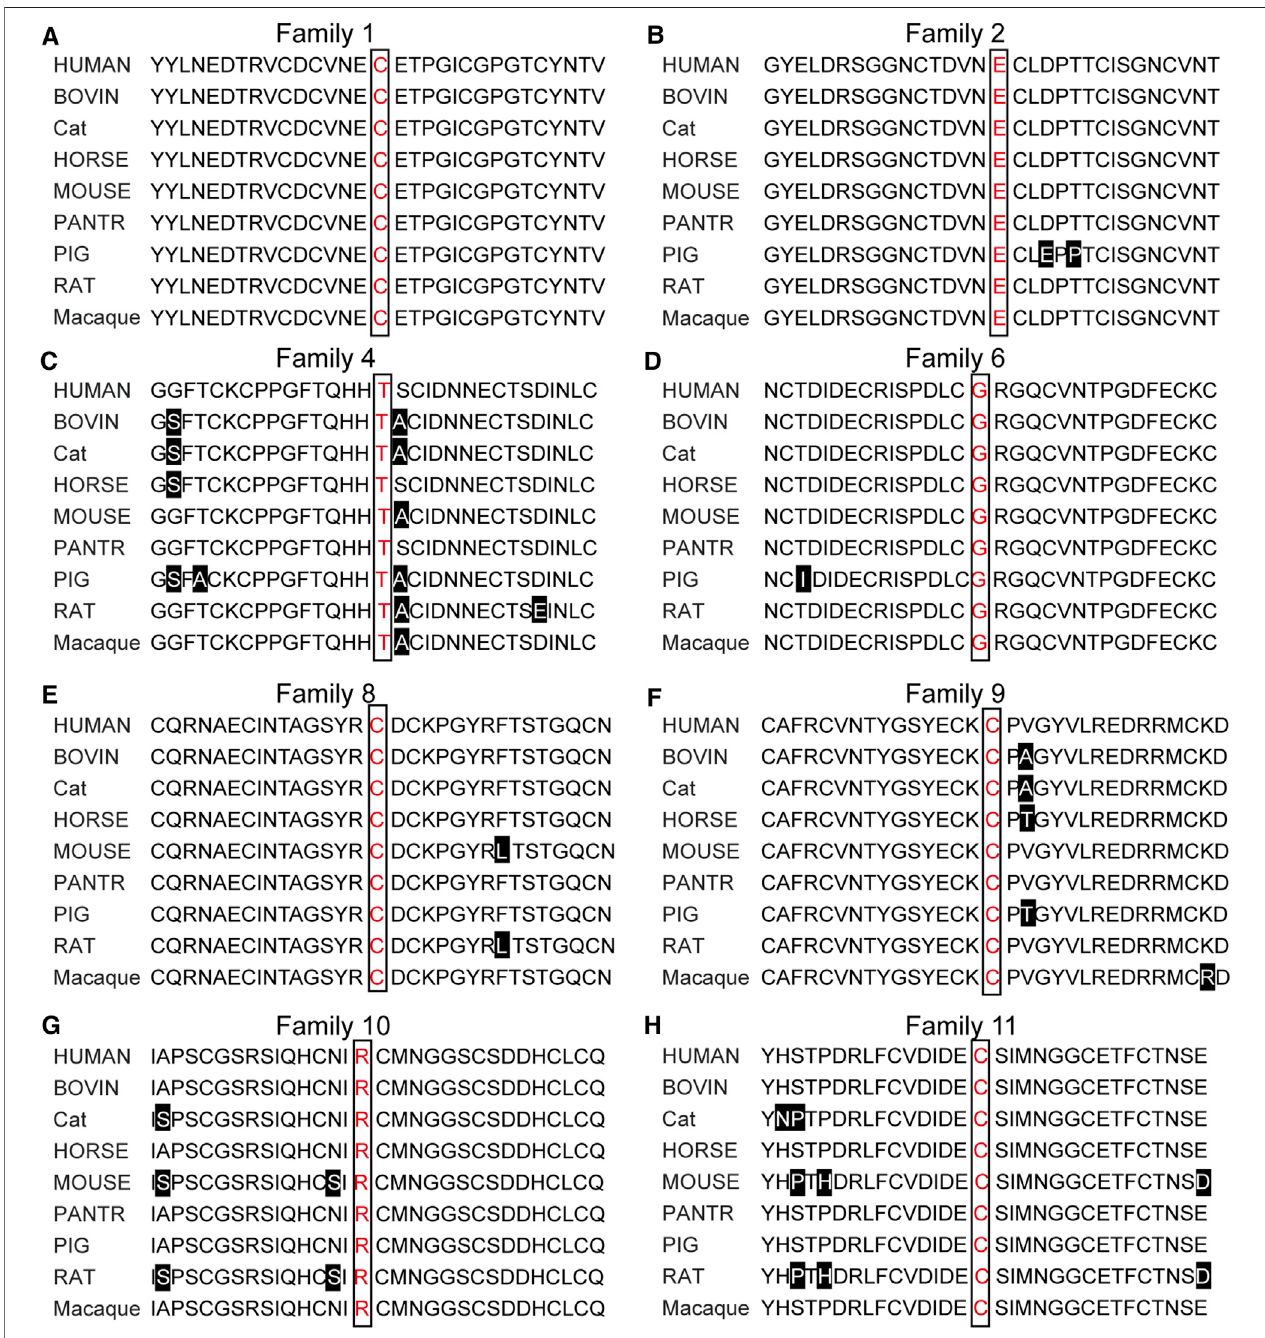
FIGURE 4 | Orthologous protein sequence alignment of FBN1 sequence. Conservation analysis among nine species showed all 11 mutations sites happened in a highly conserved region of FBN1 among different species.